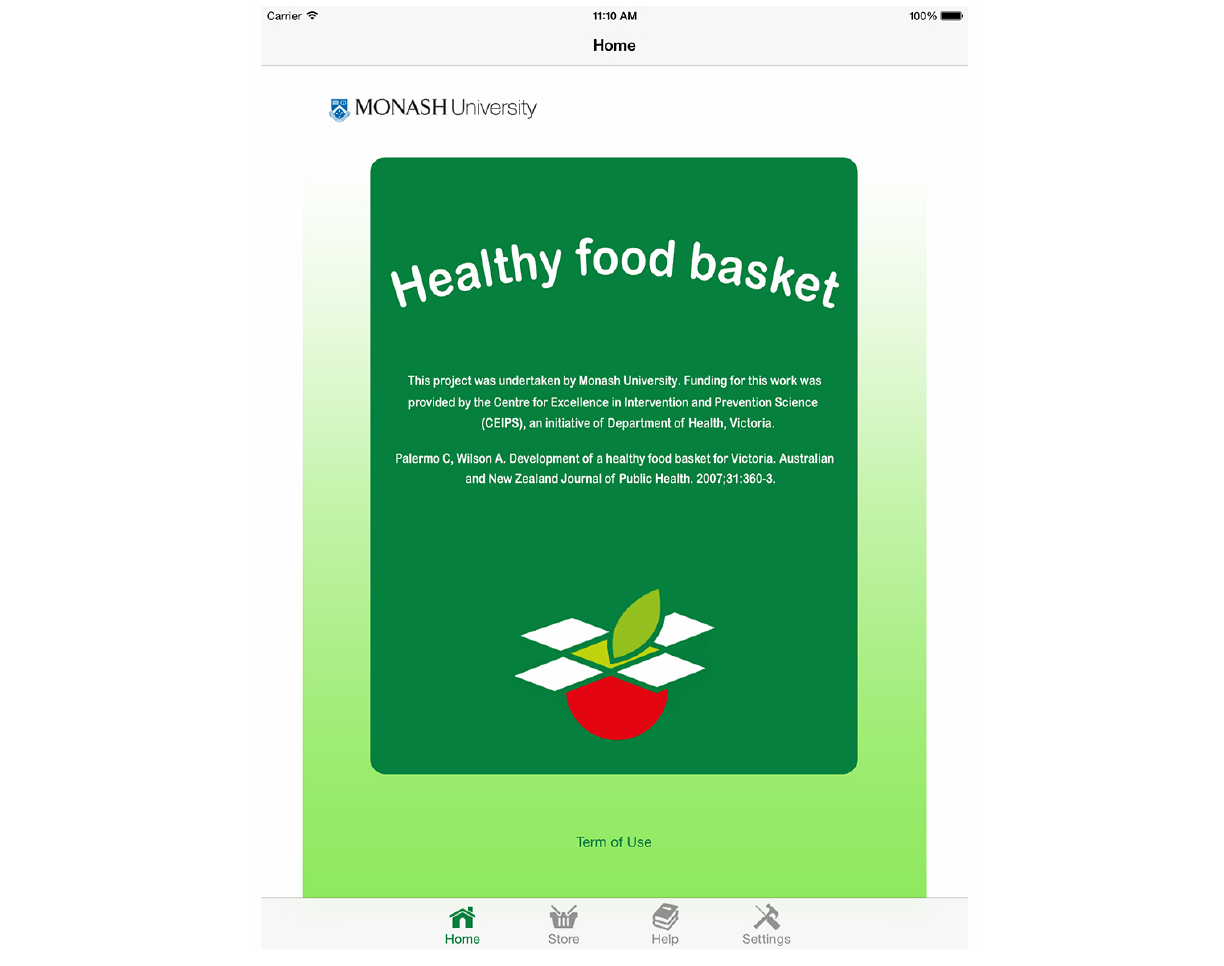
Figure 2. Home screen healthy food basket iPad app.